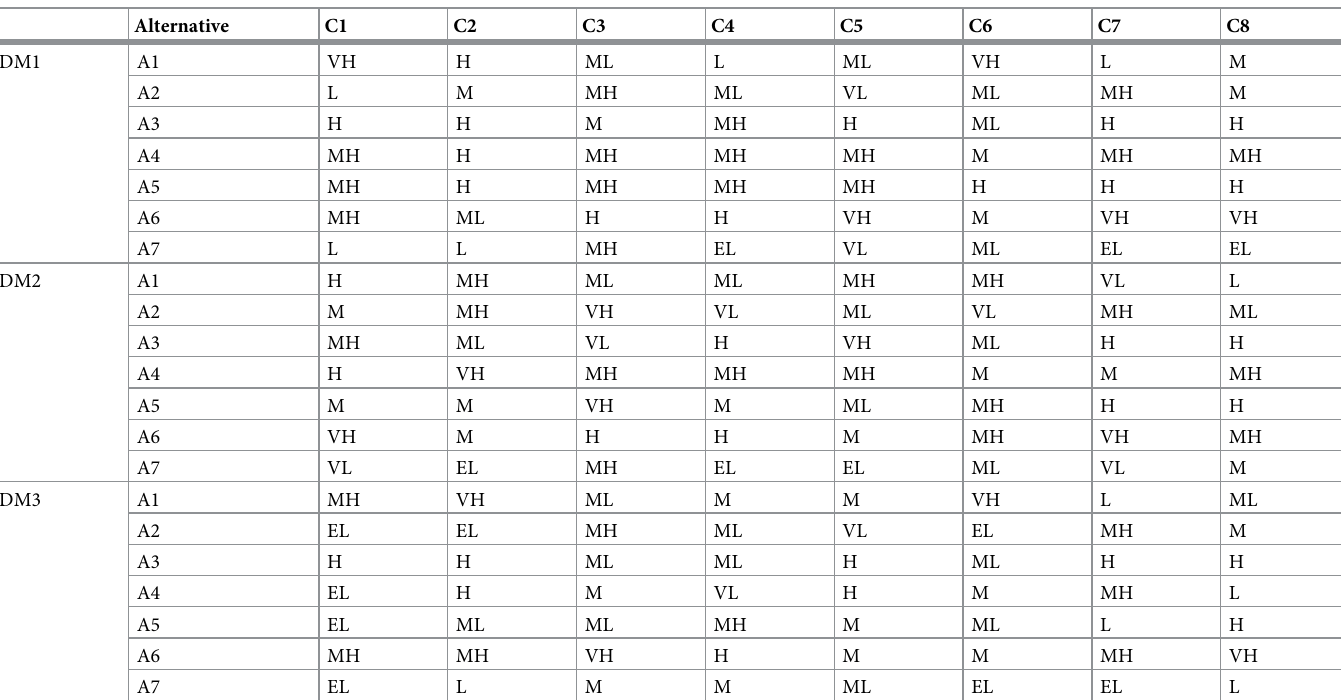
Table 2. Linguistic evaluations of alternatives. Alternative